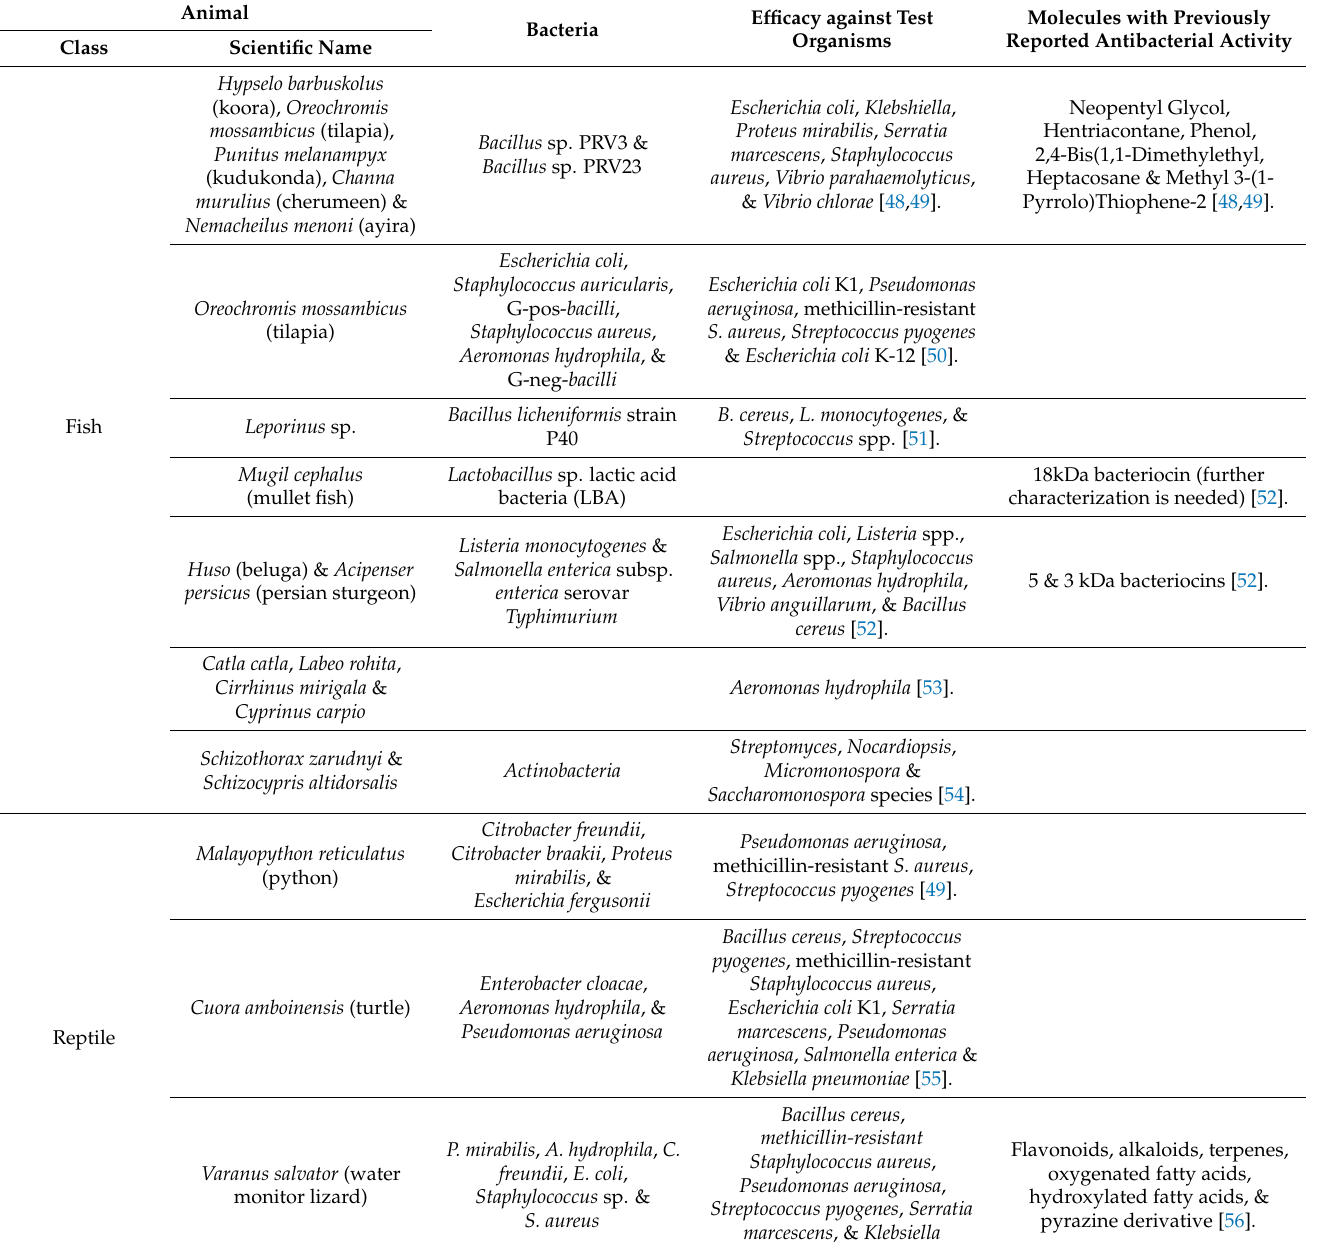
Table 1. Selected gut bacteria of reported animals and their antibacterial